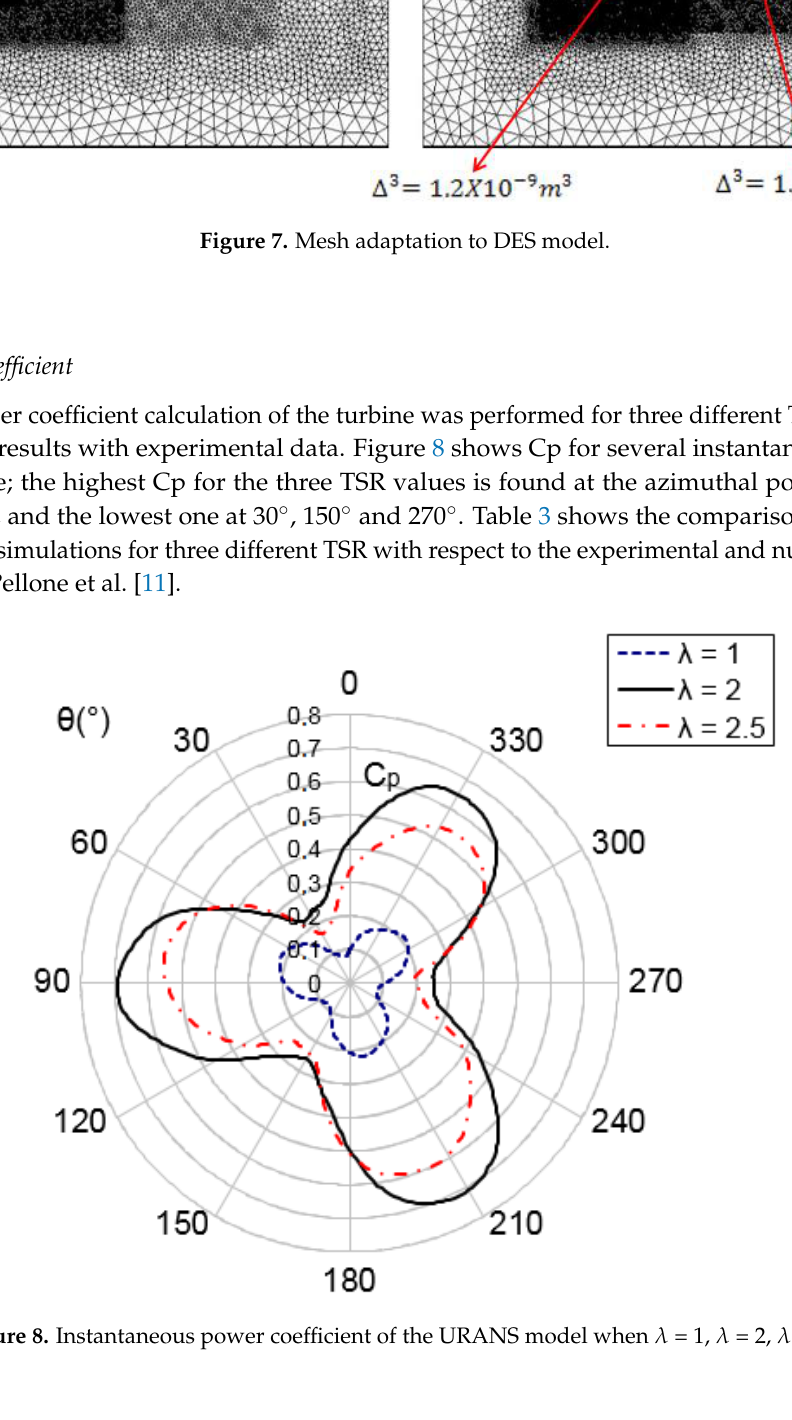
Figure 7. Mesh adaptation to DES model.